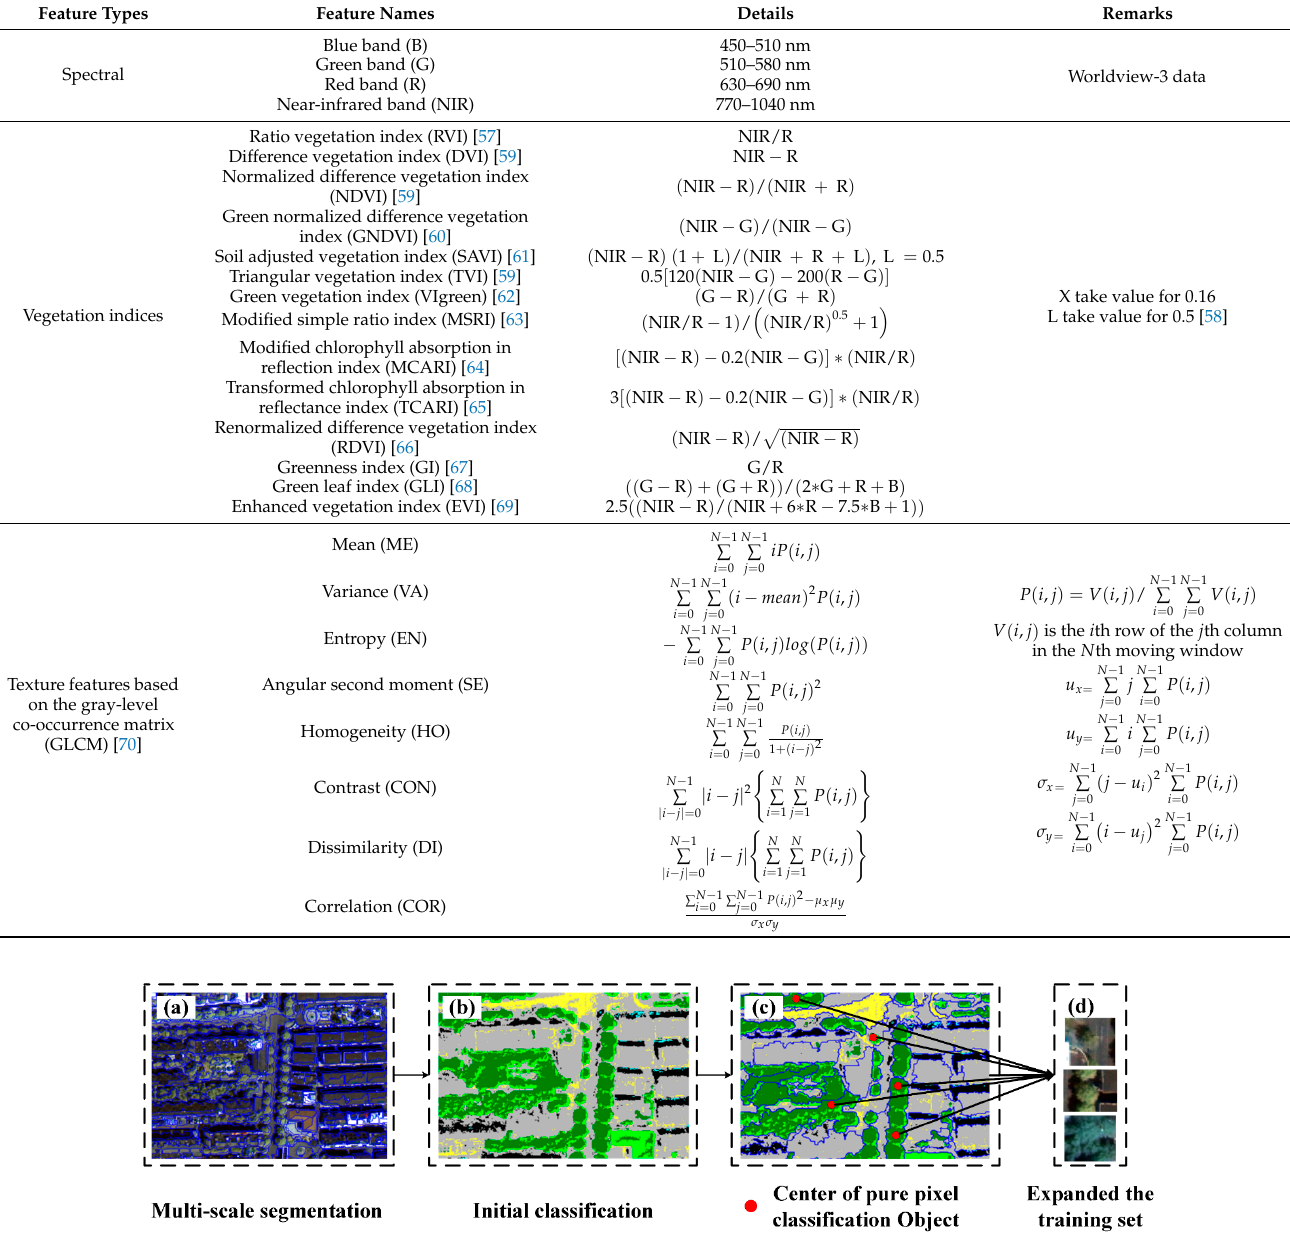
Table 3. Used variables and formulations of variables.